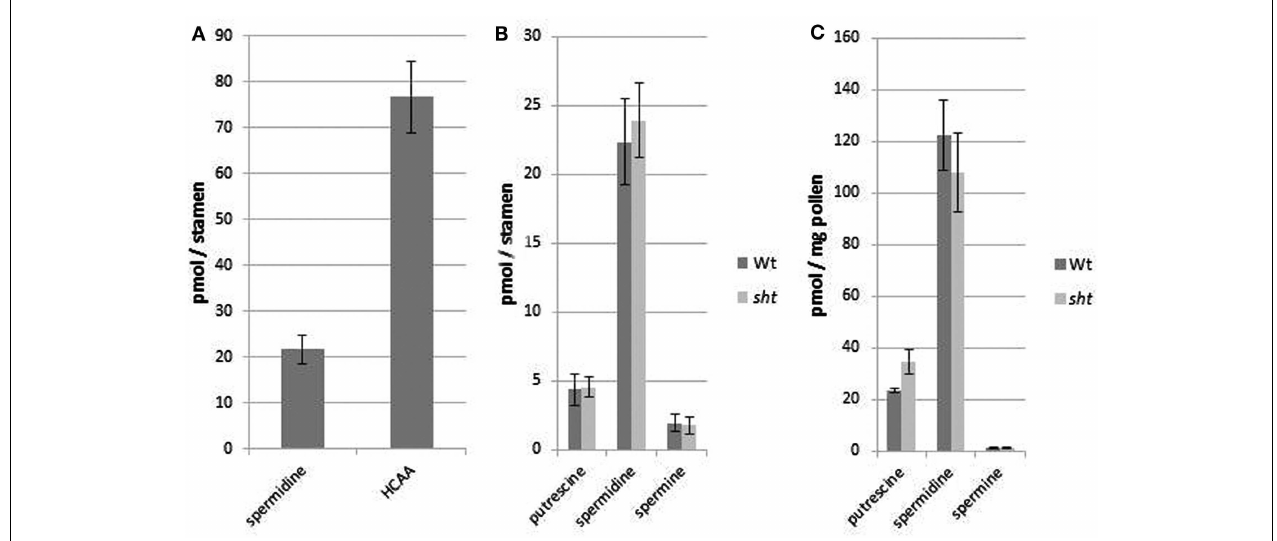
compared to the amount of free spermidine in the same organs. (B) PA content in stamen of A. thaliana wild type and sht mutant plants. (C) Total polyamine levels on purified Arabidopsis pollen grains from wild type and sht plants. Mean values ± standard deviations ( n = 3) are shown.